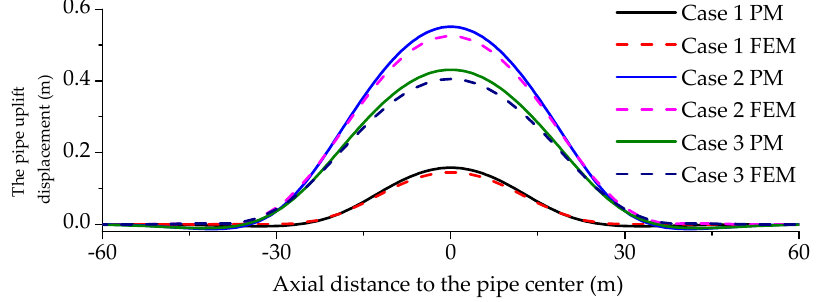
Figure 6. Pipe vertical deformation results for the considered cases.